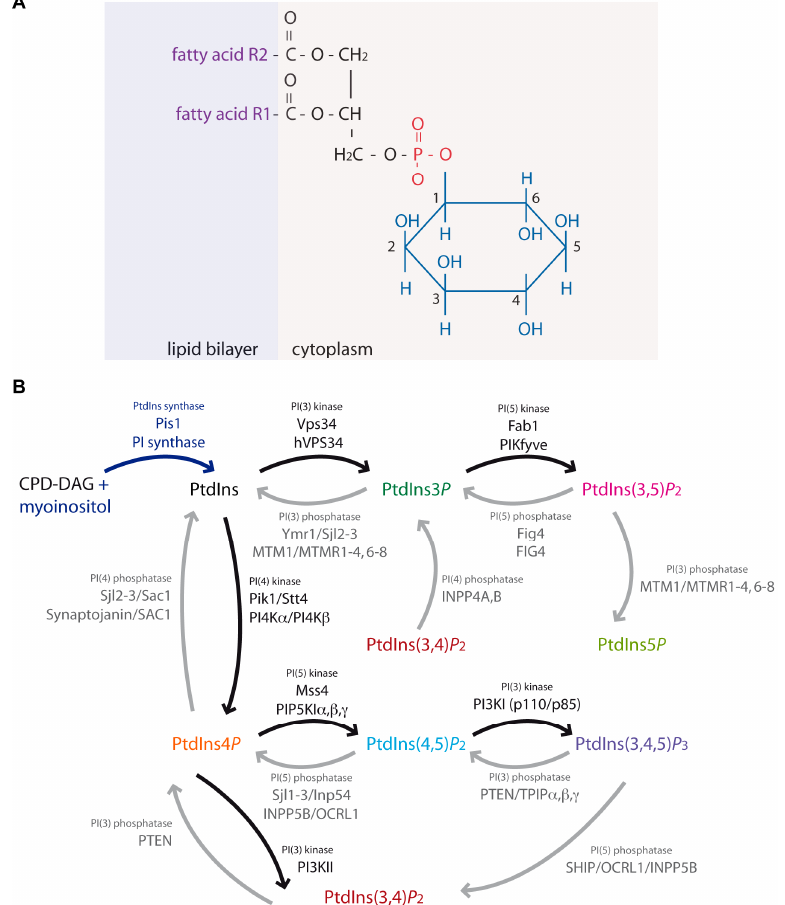
Figure 1. Phosphoinositides synthesized in yeast Saccharomyces cerevisiae (S. cerevisiae) and in human cells with the enzymes involved. ( A ) The chemical structure of phosphatidylinositol (PI); ( B ) Phosphorylation reactions are represented with black arrows and dephosphorylation reactions by grey arrows. The name of the yeast enzyme (when relevant) is written on top of its human homologue.